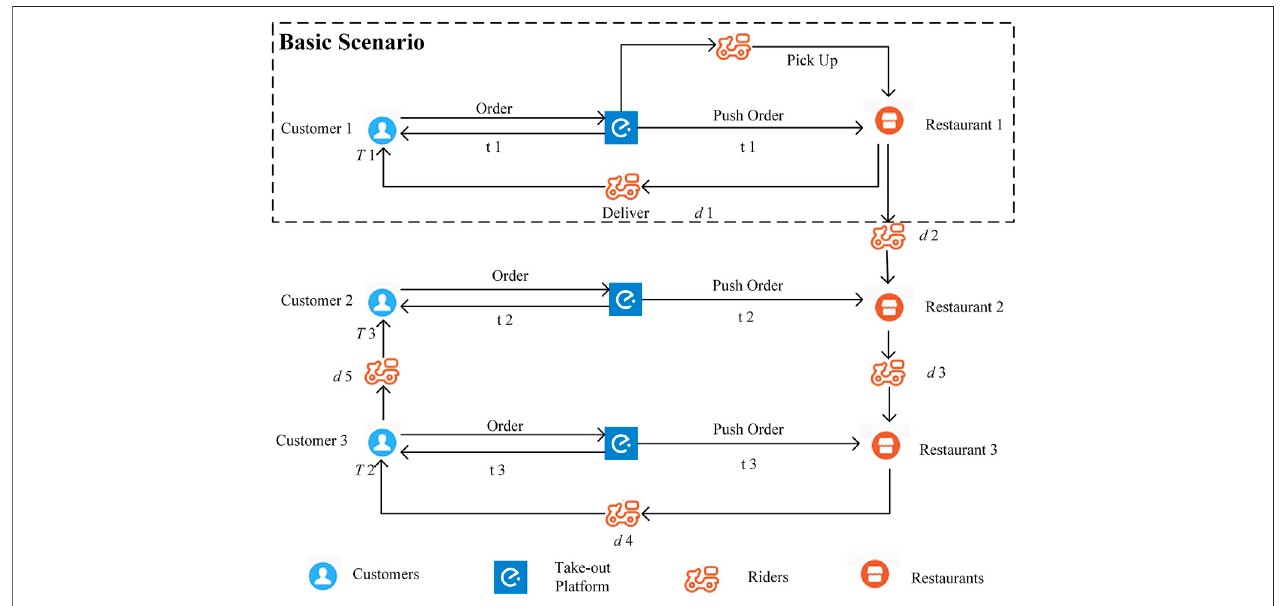
FIGURE 2 | The food delivery scenario (There are four links in the food delivery process, namely customers, takeout platform, deliverers and stores. Different delivery scenarios and links during the delivery process are shown in the fi gure).